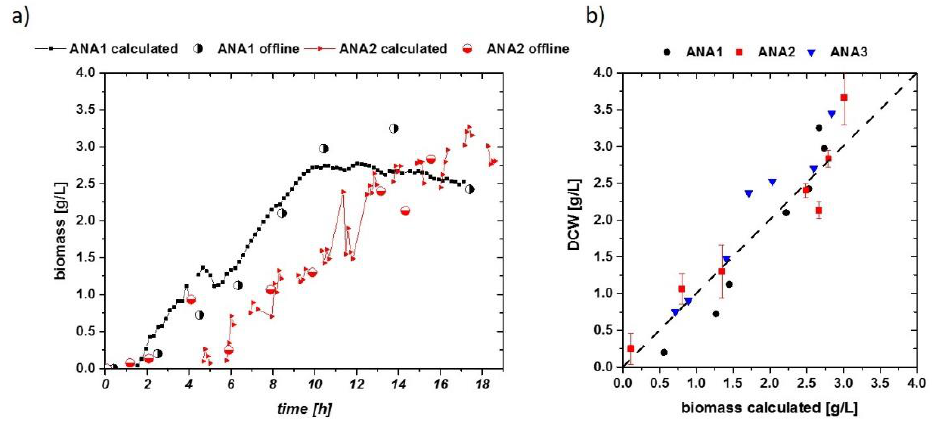
Figure 5. ( a ) Biomass calculated from the impedance signal fit extracted in Figure 4a, including offline- measured DCW values as circles. Flow cytometric measurements confirmed that no dead population is visible; thus, DCW can be compared to the viable cell concentration (VCC) in these runs. ( b ) Residual analysis of the three anaerobic runs. Despite the low cell densities, a very accurate correlation can be found in all cultivations. Error bars are exemplarily plotted for the ANA2 cultivation.